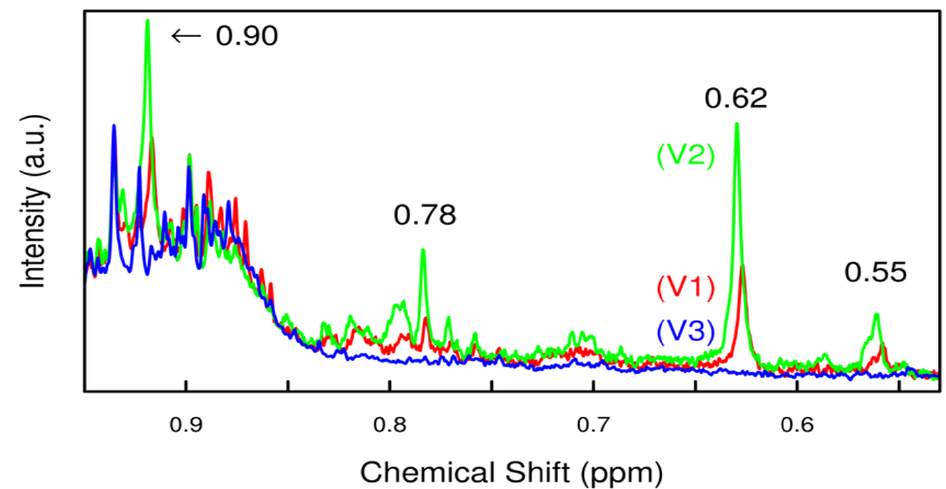
Figure 3. The four influential NMR signals over time [36].